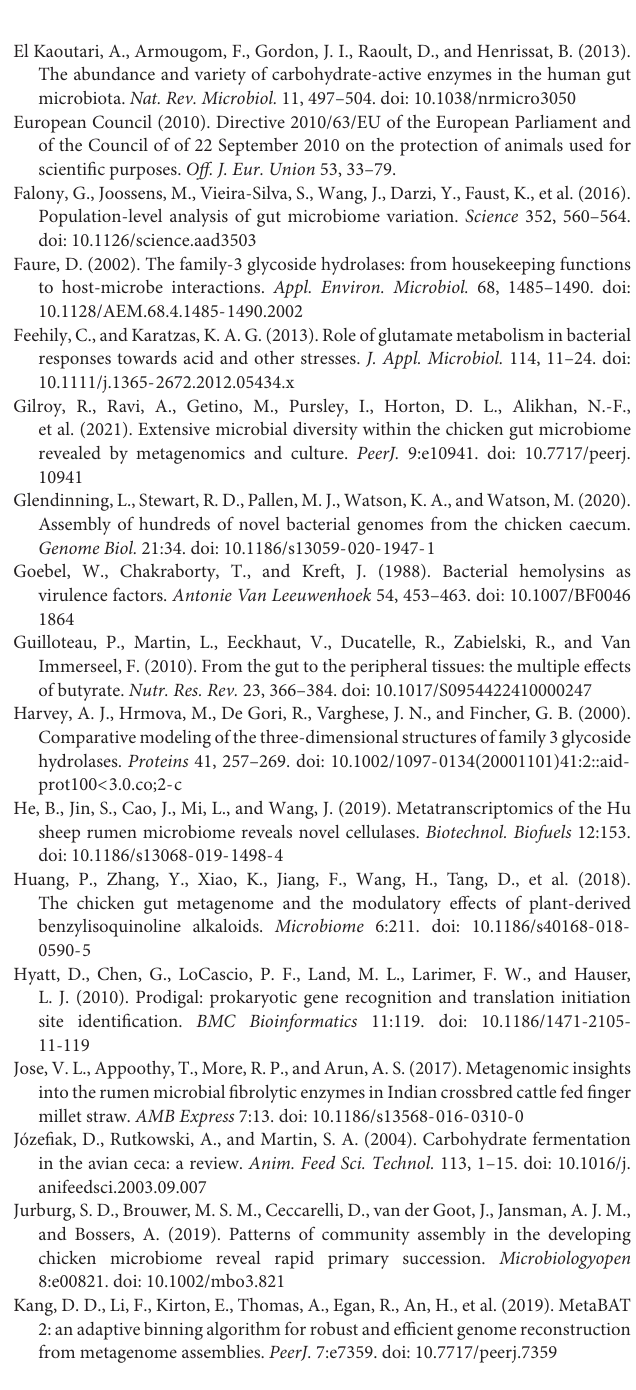
Supplementary Table 4 | Log2 fold changes and adjusted p values for MAGs with significant differential abundance between day 35 and 3. Supplementary Table 5 | Total number of CAZymes by category identified in each genome and the percentage of CAZymes in comparison to the total predicted proteins for each MAG. Supplementary Table 6 | Proteins present in the MAGs related to interaction with the host. Supplementary Table 7 | Prevalence of CAZyme genes in each